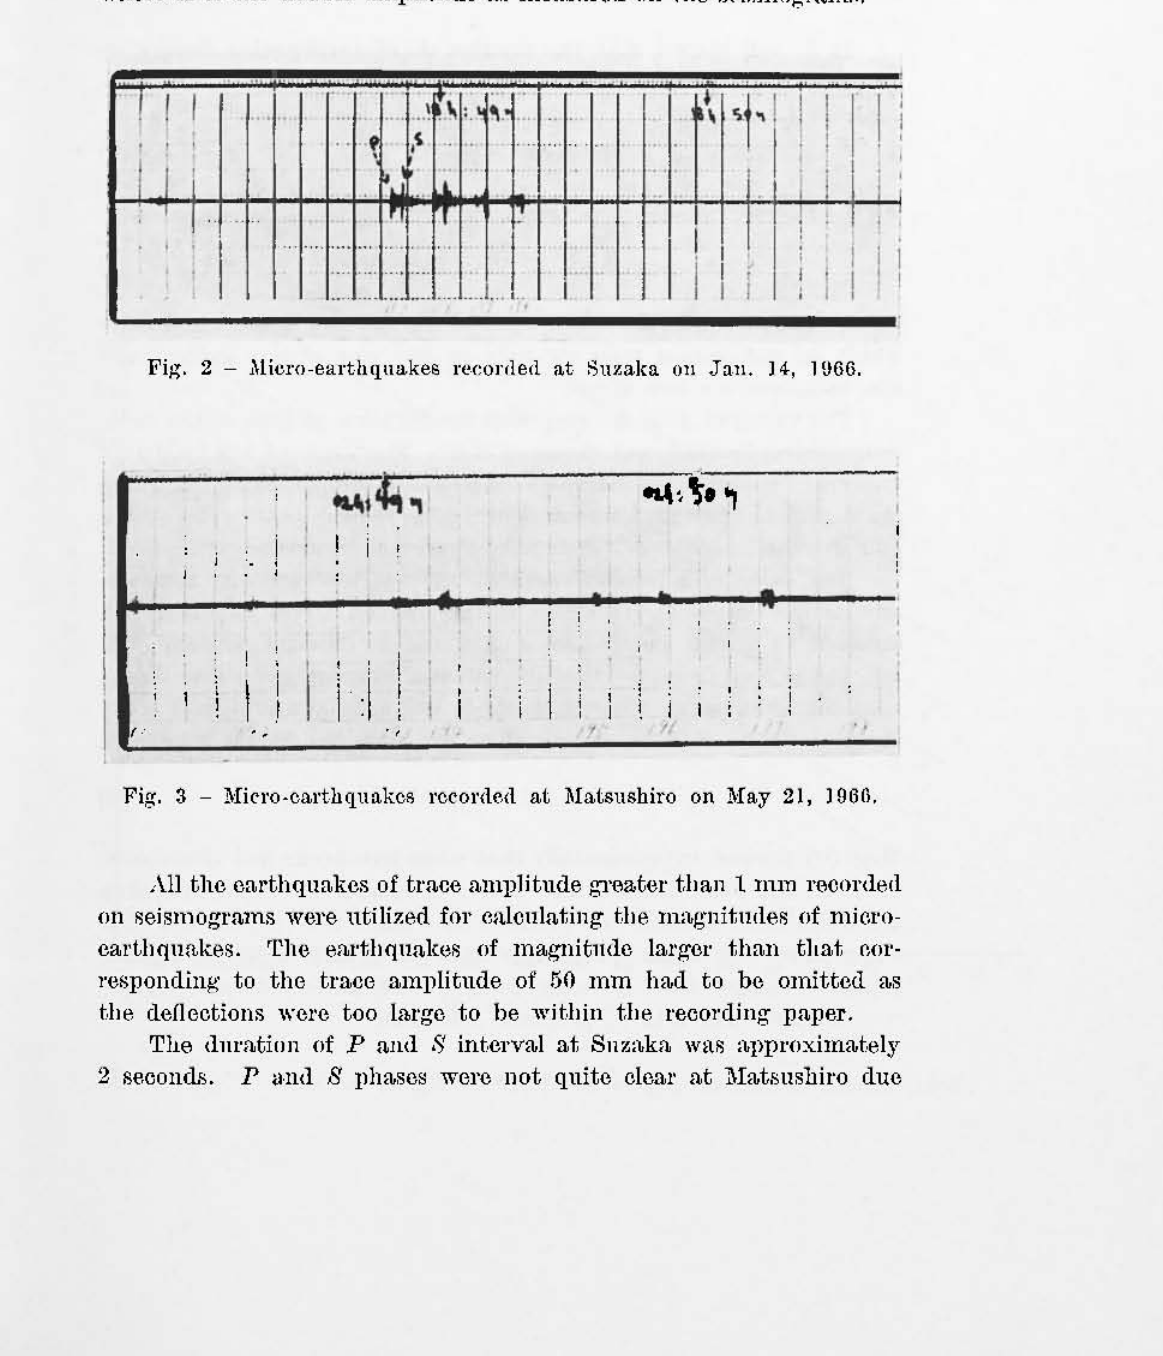
Fig, 2 - Micro-eartlul!Jakes reeonled at ~uzaka 011 Ja11. 14-,